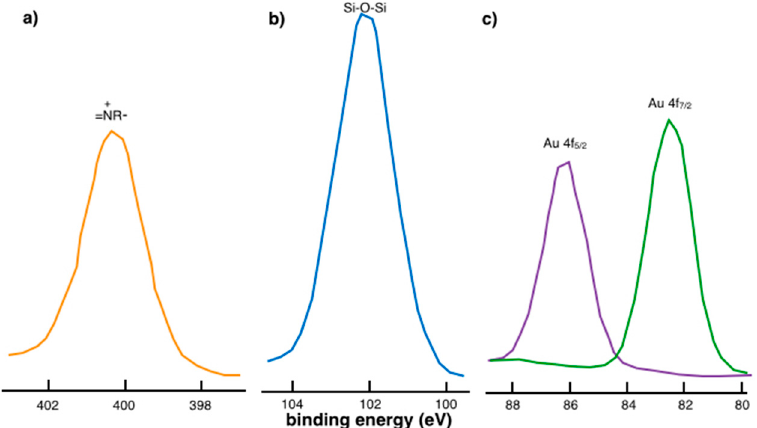
Figure 3. Core level regions X-ray photoelectron spectroscopy (XPS) spectra of the supported AuNPs for ( a ) N 1s, ( b ) Si 2p, and ( c ) Au 4f.